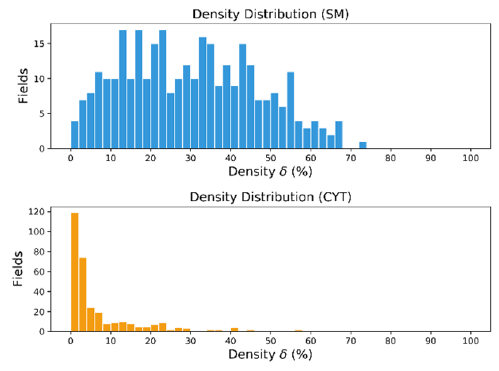
Figure 10. Comparison of density distributions.